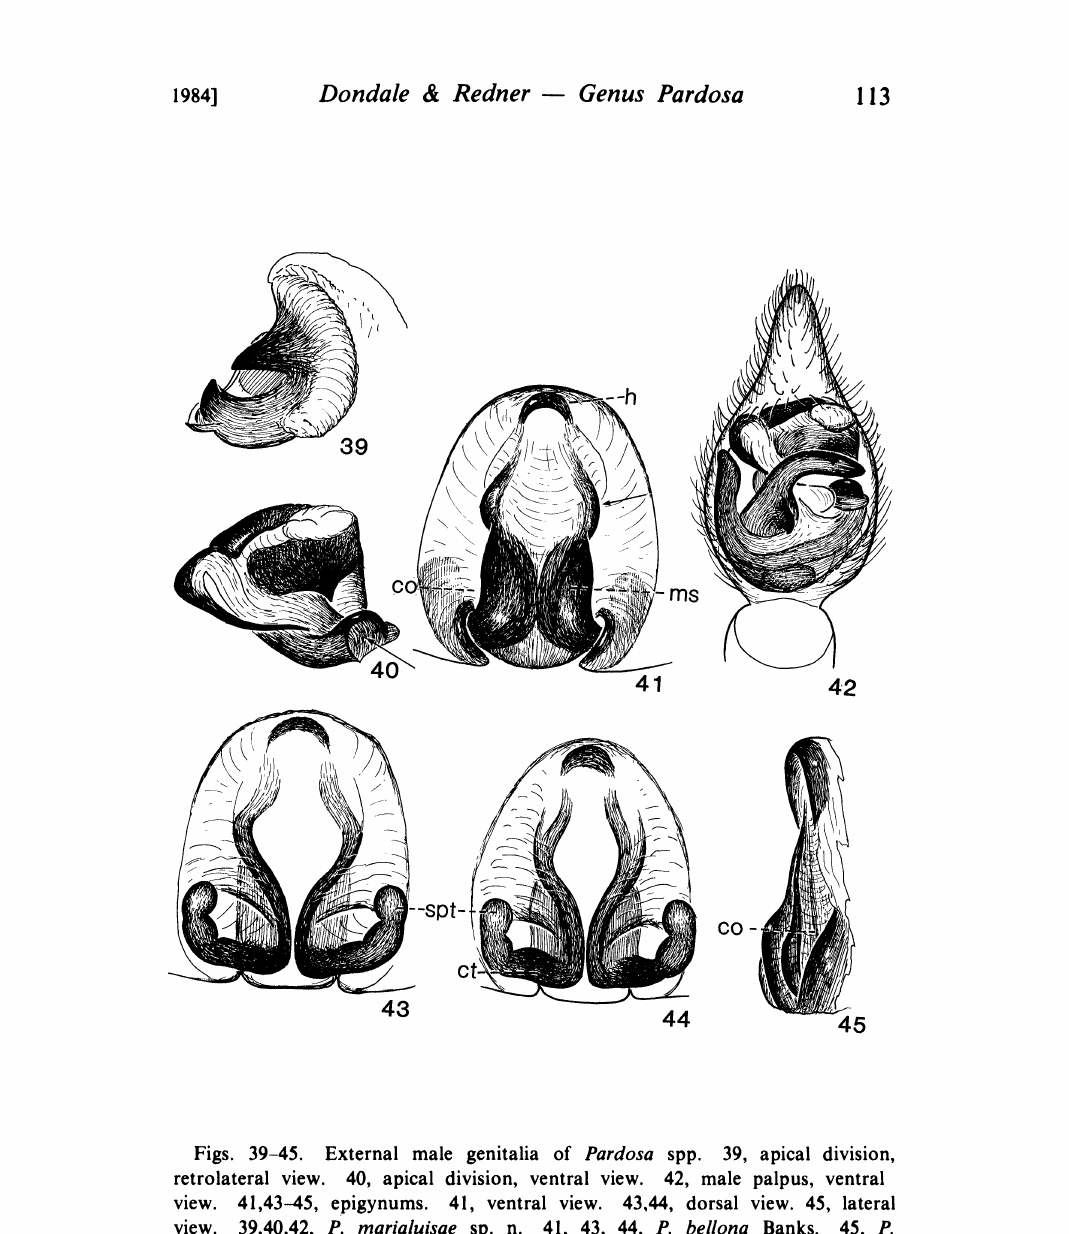
Figs. 39-45. External male genitalia of Pardosa spp. 39, apical division, retrolateral view. 40, apical division, ventral view. 42, male palpus, ventral view. 41,43-45, epigynums. 41, ventral view. 43,44, dorsal view. 45, lateral view. 39,40,42, P. marialuisae sp. n. 41, 43, 44, P. bellona Banks. 45, P. delicatula Gertsch and Wallace. co, copulatory opening, ct, copulatory tube. h, hood. ms. median septum, spt,